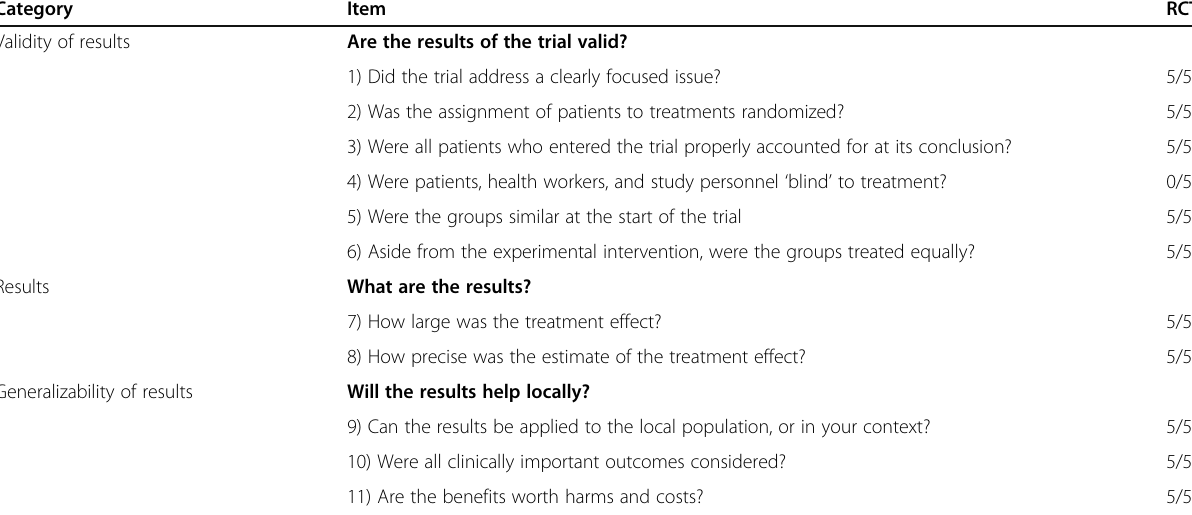
Table 1 Quality assessment of studies Category Item Validity of results Are the results of the trial